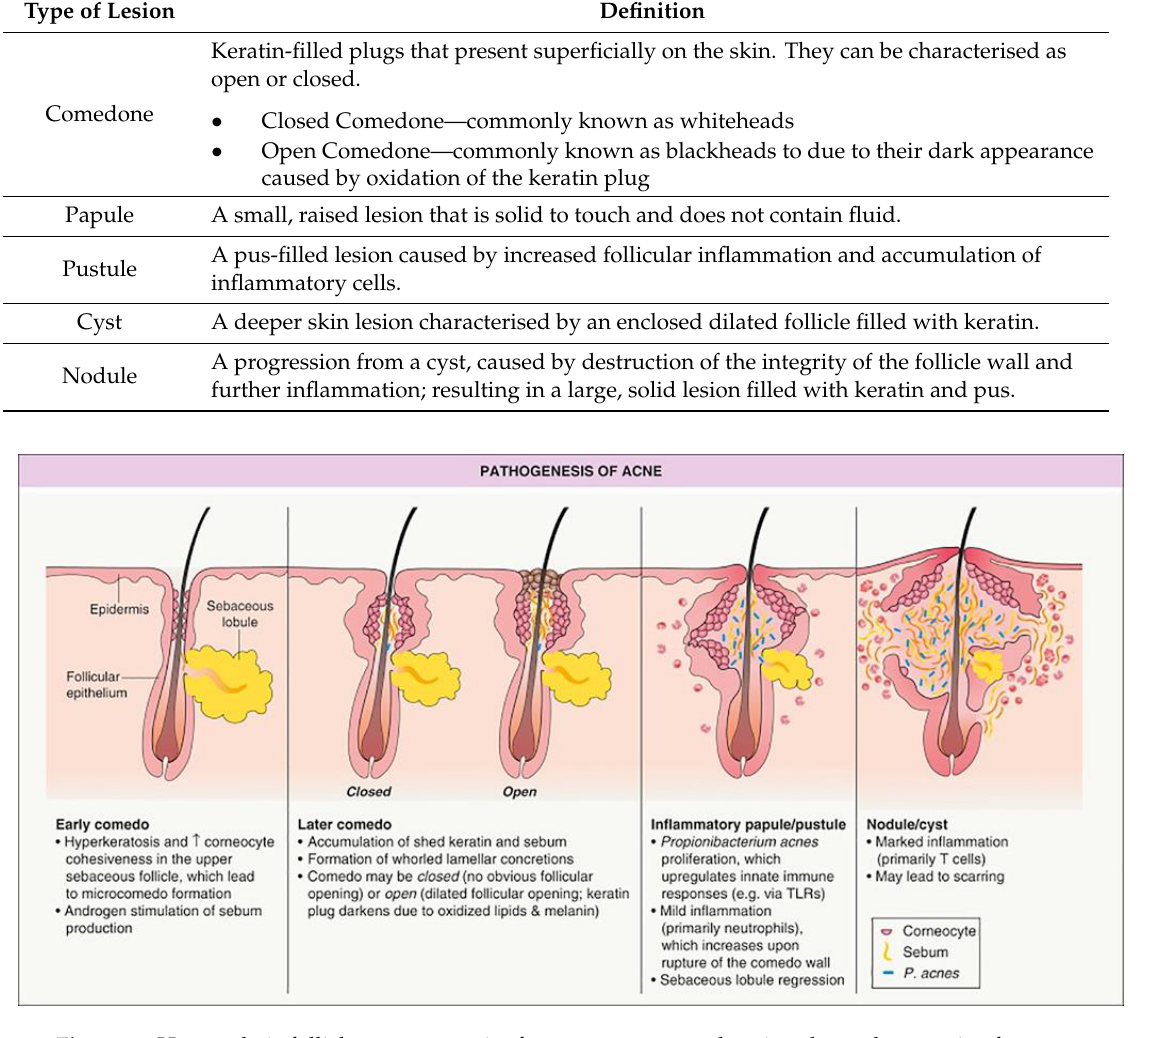
Figure 1. Human hair follicle as a target site for acne treatment showing the pathogenesis of acne: early stage to closed comedo (whitehead) and open comedo (blackhead), papule, pustule and cyst. Reproduced with permission [3], Elsevier, 2012.